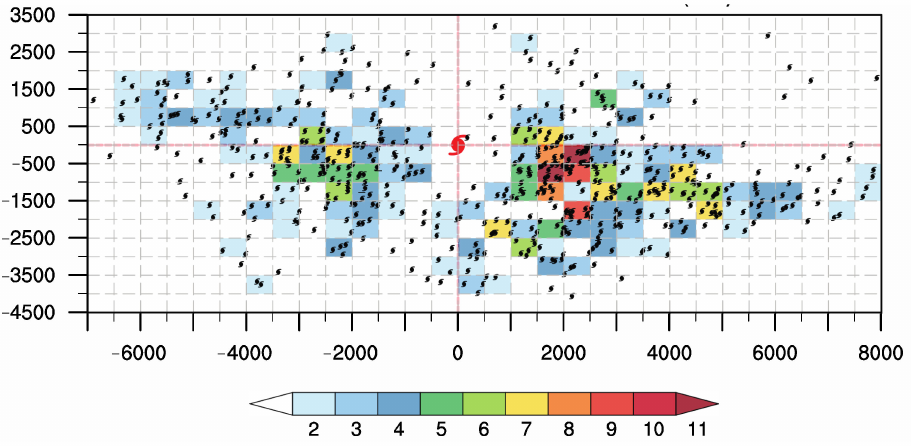
Figure 4. Relative distances (units: km) between the pre-existing and newly formed TCs in a pair. The red hurricane symbol indicates the pre-exiting TC, and black ones give the relative positions of the new TCs. The number of new TCs within a 500 km × 500 km grid is color